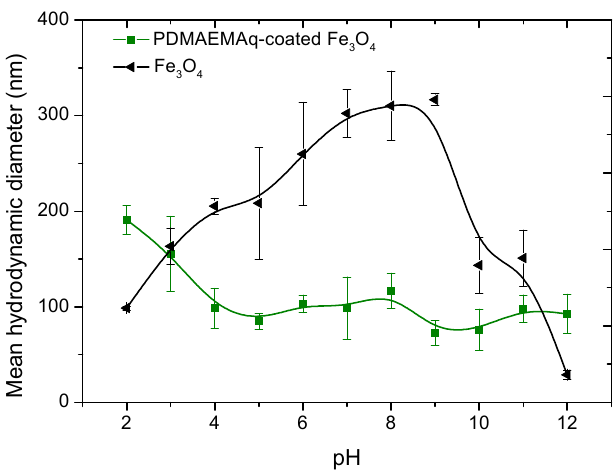
Figure 8. Effect of pH on the particle size of magnetite nanoparticles before and after PDMAEMA coating.